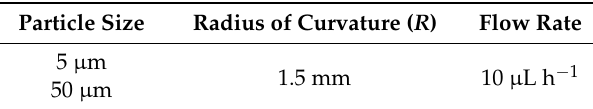
Table 1. Fixed parameters for calculations.